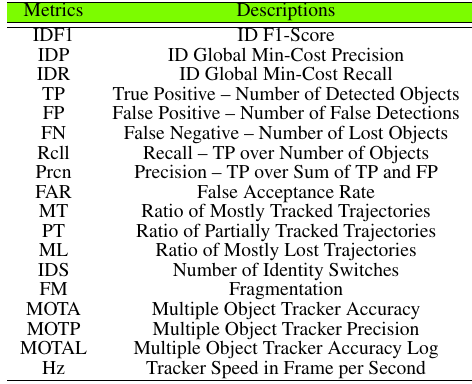
Table 1. Descriptions of the metrics used for quantitative